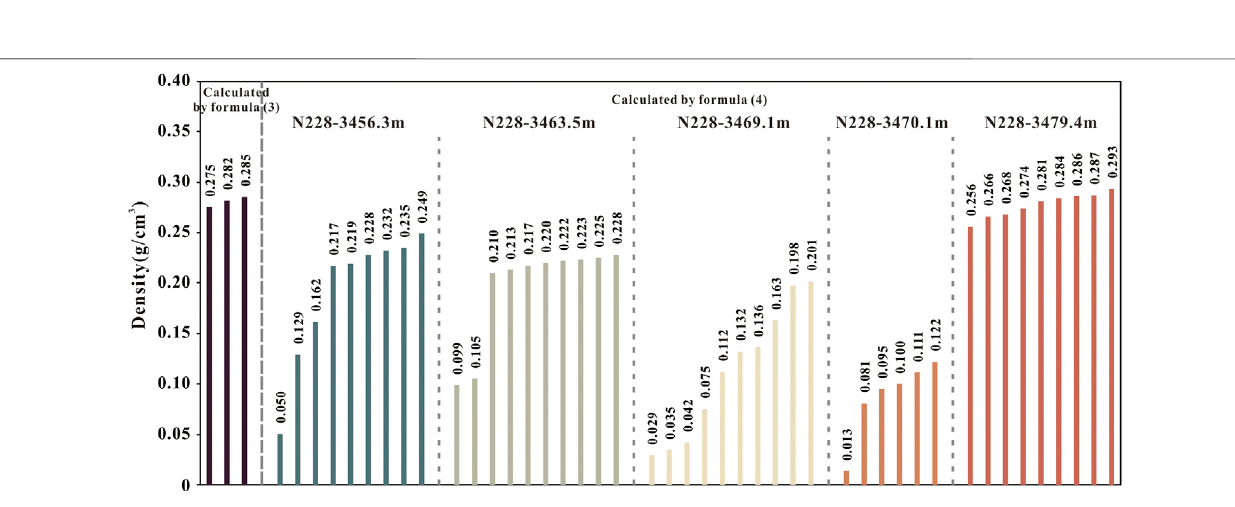
FIGURE 9 | Density distribution calculated by low-temperature method and Raman spectroscopy